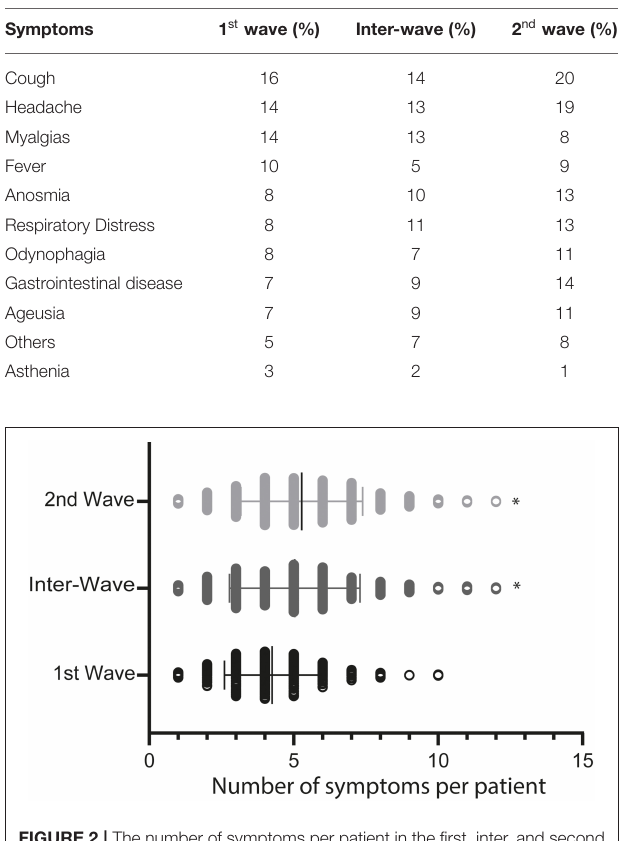
TABLE 3 | Deceased and recovered by gender, in the three periods analyzed (number).